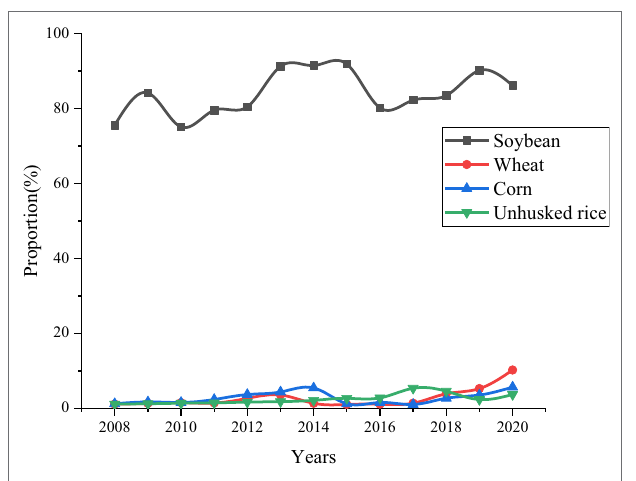
FIGURE 5 | Import dependence on major agricultural products during 2008– 2020.